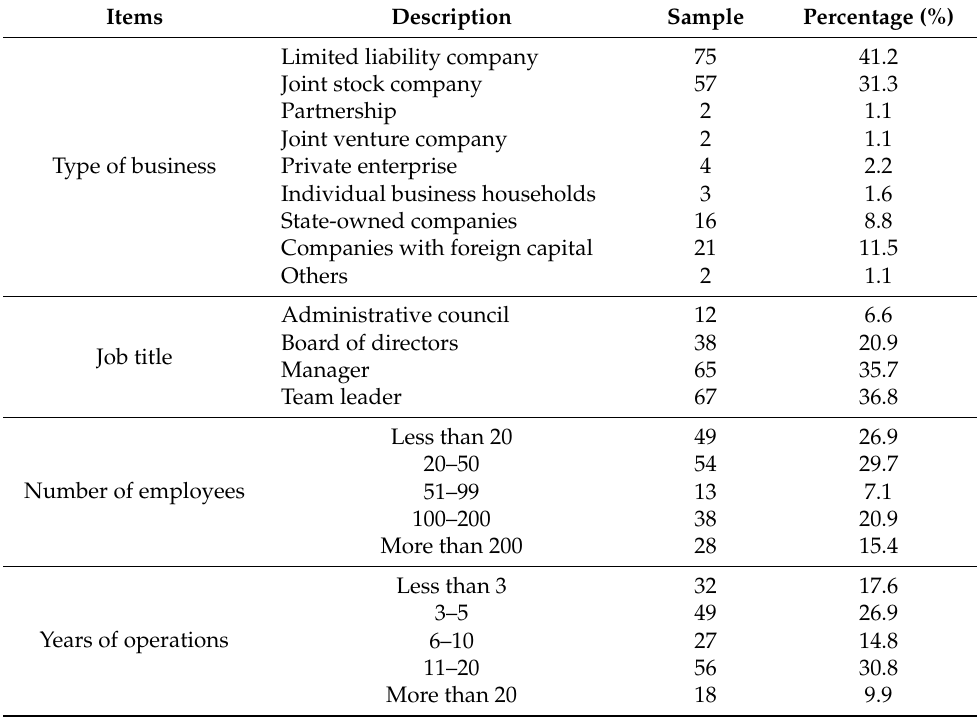
Table 1. Demographic characteristics ( N =